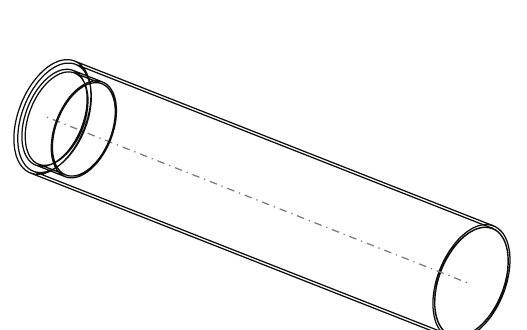
Figure 1: Proposed scheme of pulse cleaning system.